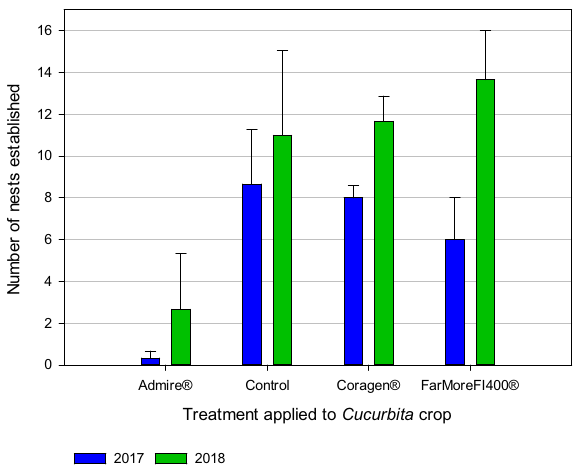
Figure 1. Numbers of hoary squash bee ( Eucera ( Peponapis ) pruinosa ) nests constructed over the 2017 and 2018 seasons in hoop houses in which one systemic insecticide treatment (either Admire-imidacloprid, applied to soil at seeding; or Coragen-chlorantraniliprole applied as a foliar spray; or FarMore FI400-thiamethoxam applied as a seed treatment) was applied to the Cucurbita acorn squash (Varieties: Table Star (2017), Celebration (2018)) crop 8-weeks before the bee active period, or the crop remained untreated as a control. Data presented are means ± SE across three hoop houses per treatment in each